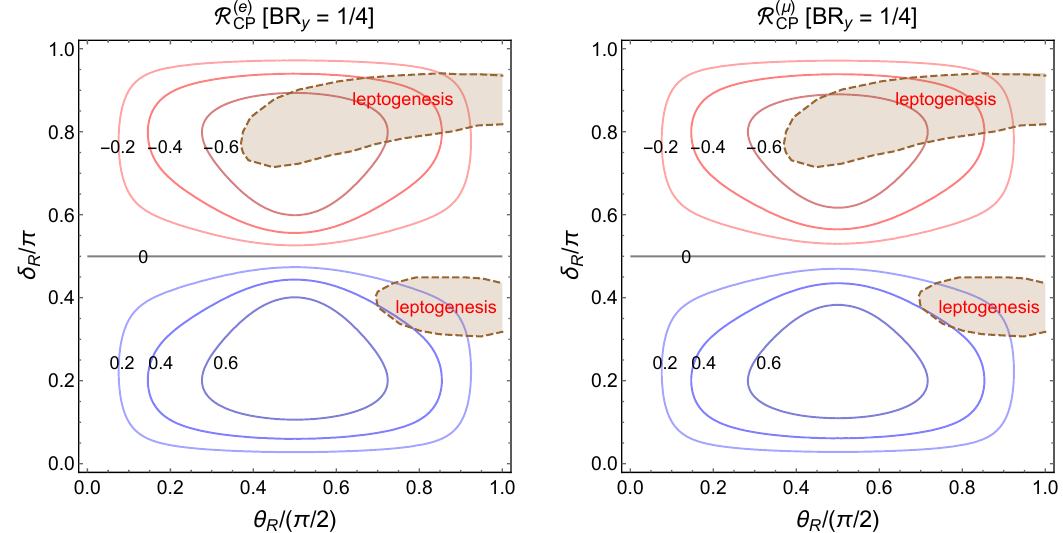
( e ) ( (cid:22) ) (left) and (right) as functions of the RHN mixing CP CP R R = 20 TeV. The brown shaded regions R